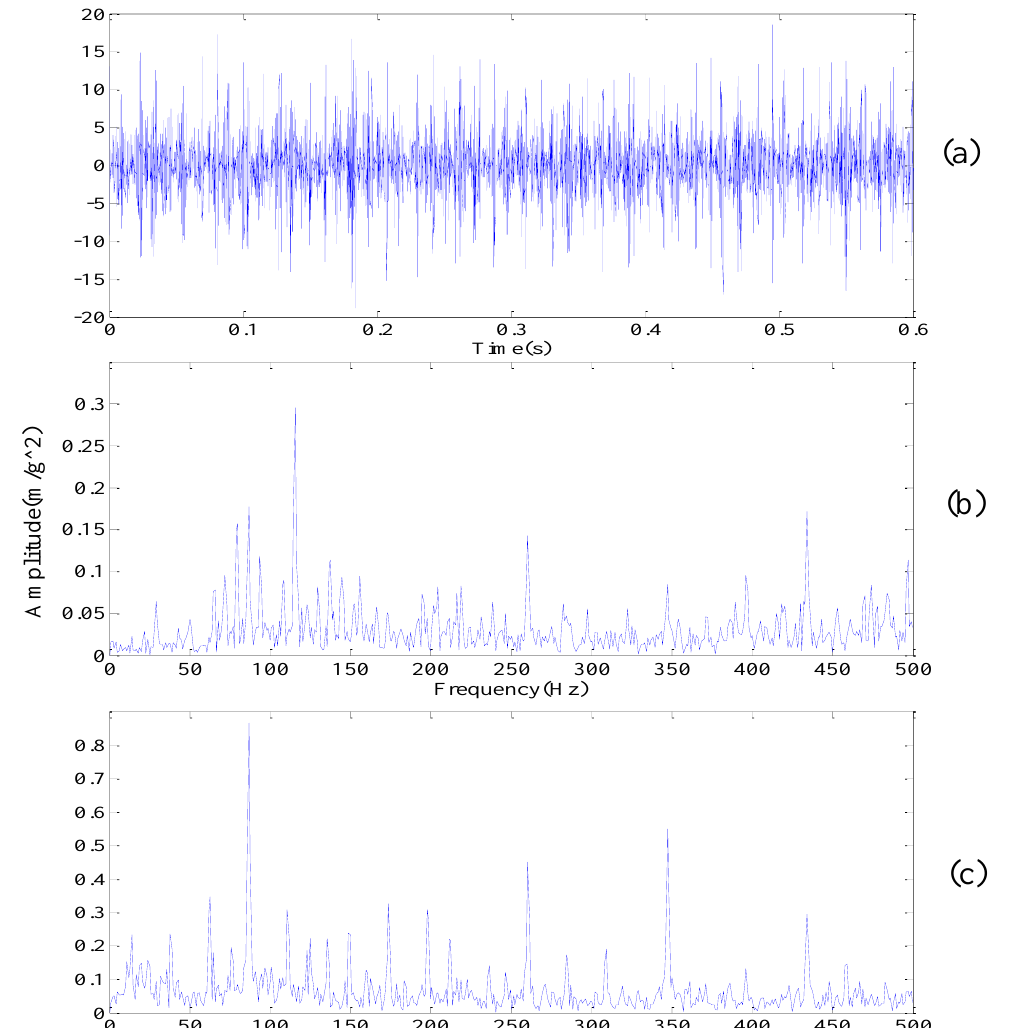
Figure 7. The measured signal in the time domain and frequency spectrum: ( a ) time domain; ( b ) FFT spectrum; ( c ) envelope spectrum.